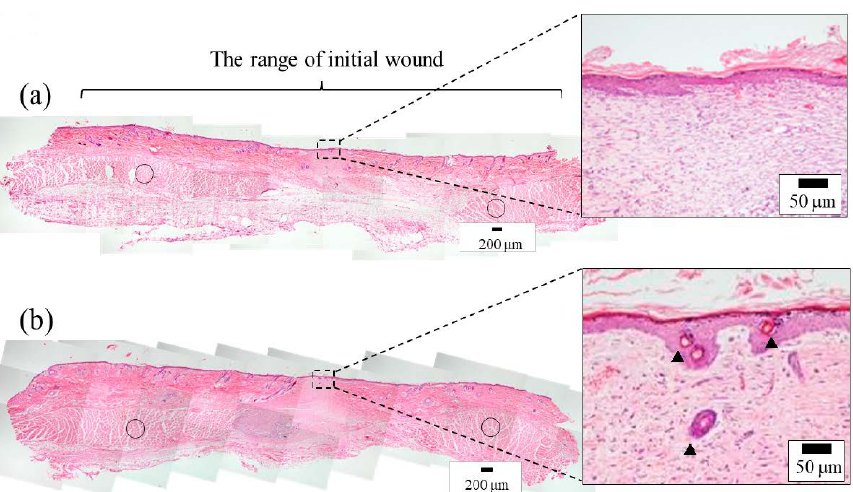
Figure 9. An overall view of the HE-stained skin after 4 weeks and the HE images focusing on the regenerated skin area: ( a ) control group and ( b ) simonkolleite group. The symbols of ○ and ▲ mean muscle tissue and hair follicle, respectively.